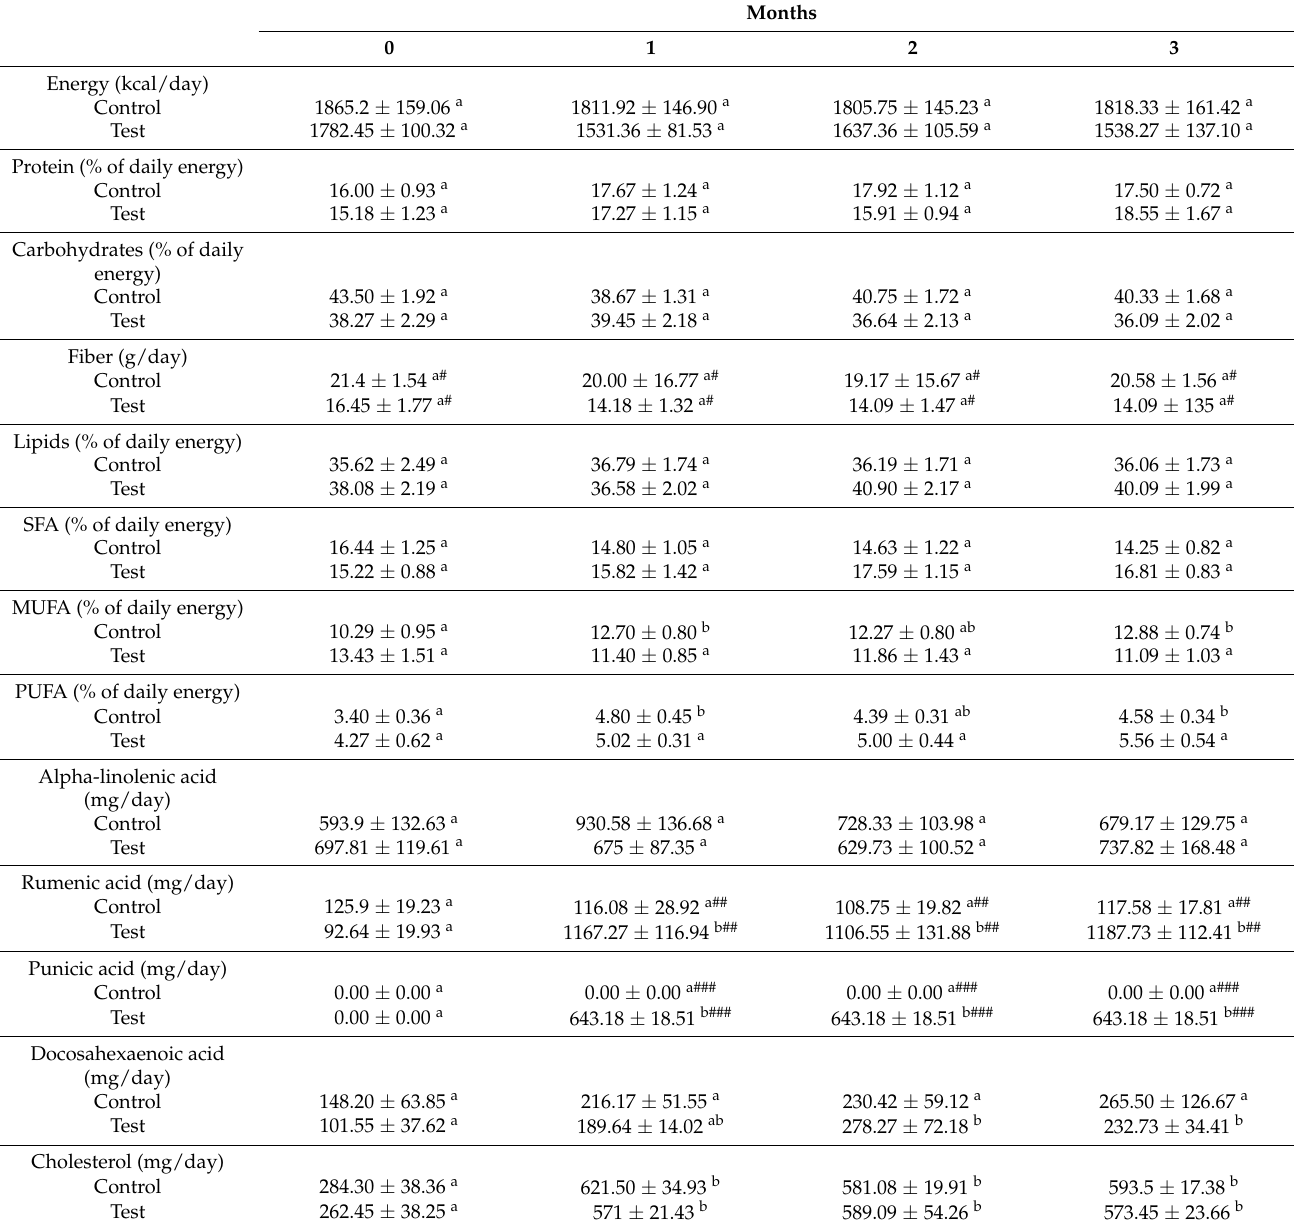
Table 3. Dietary intake of study participants based on the 3-day food